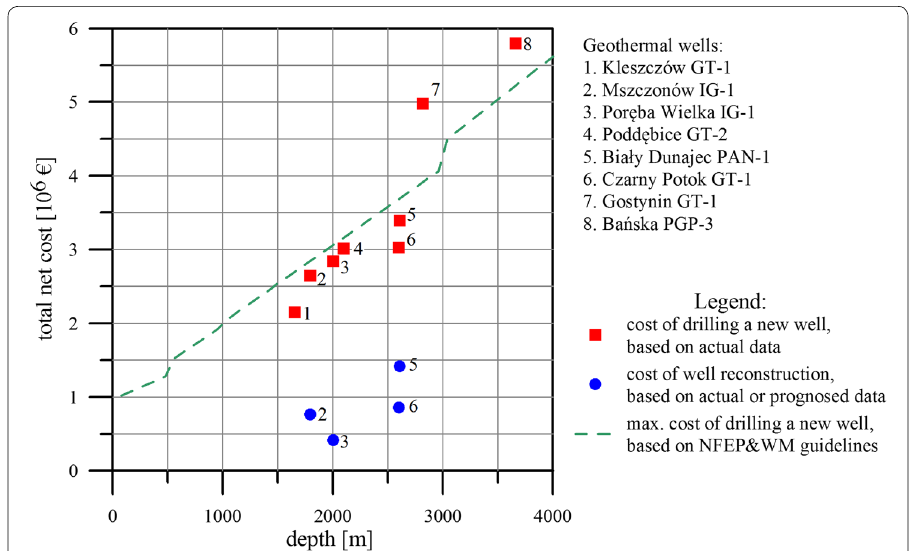
Fig. 16 A summary of the actual costs of drilling and reconstructing selected geothermal wells in Poland